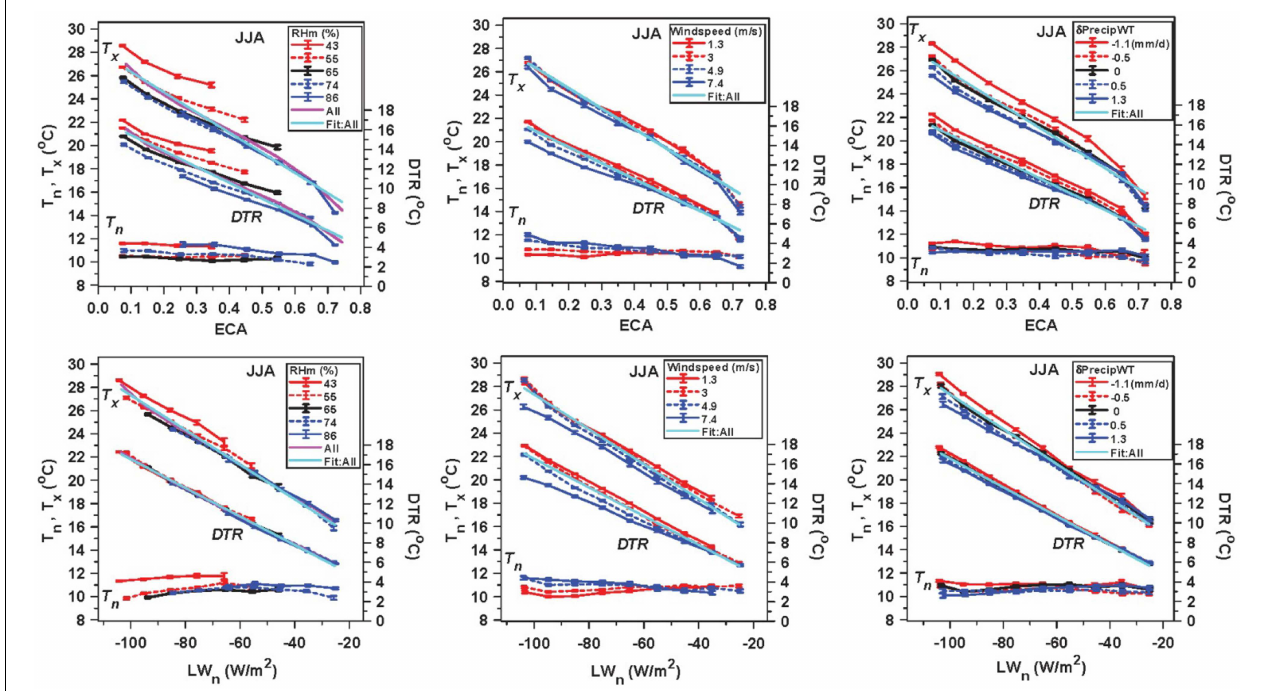
FIGURE 13 | ECA (upper row) and LW n (lower row) dependence of T x , T n , and DTR for the RH m , windspeed and precipitation anomaly stratifications.